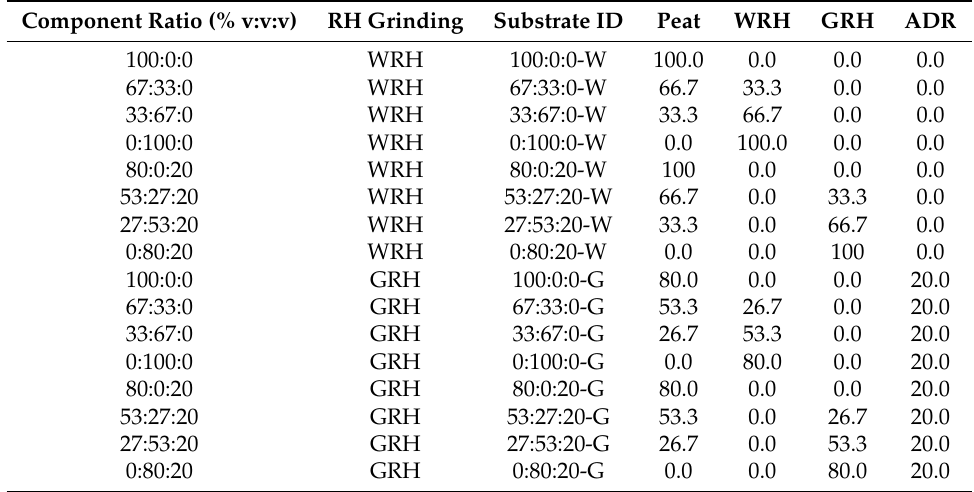
Table 1. Volumetric ratio of peat (P), rice hulls (RH), either whole (WRH), or ground (GRH), and anaerobic digestion residues (ADR) in the evaluated substrates.